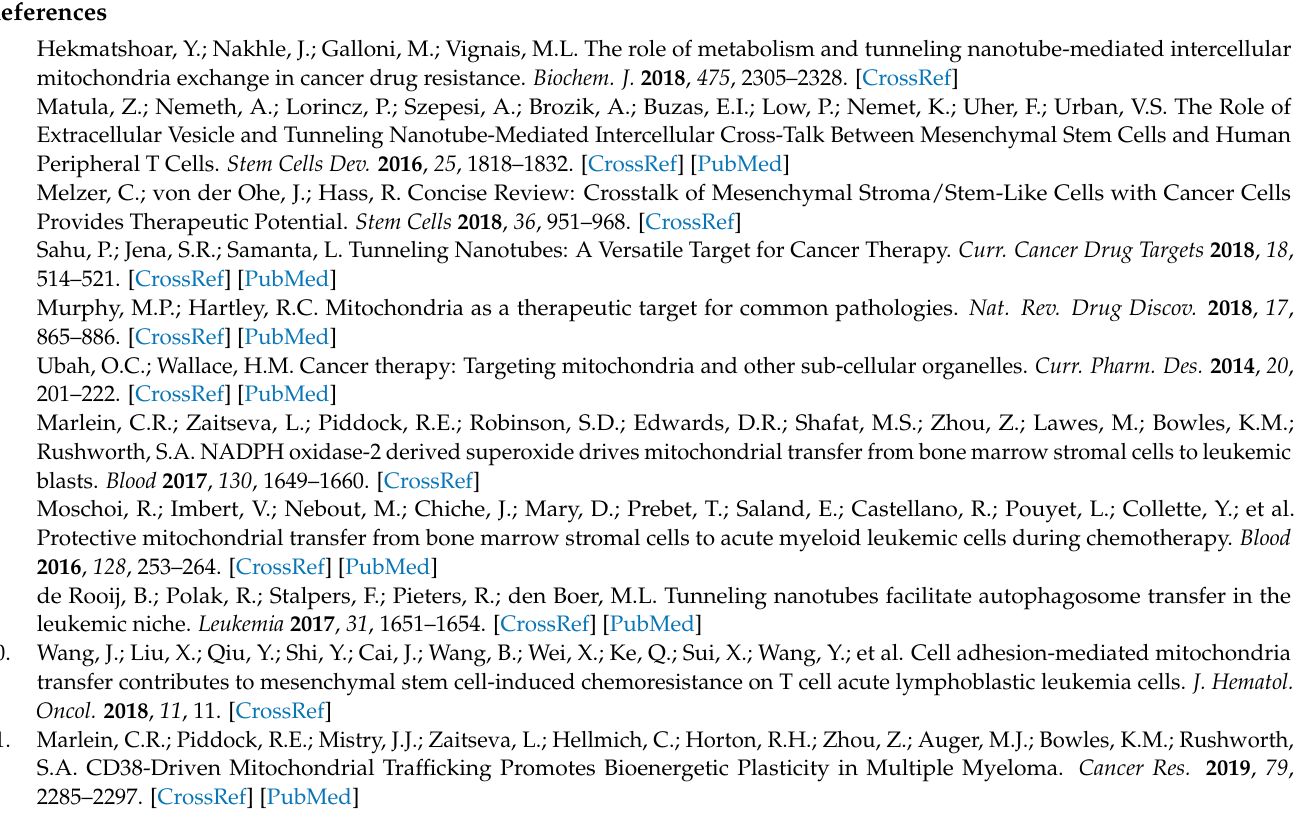
Figure S7: Lentiviral transduction of BM-MSCs or MM cells with pCT-Mito-GFP lentiviral particles, Figure S8: Illustration of gating strategies for FACS analysis of mitochondrial